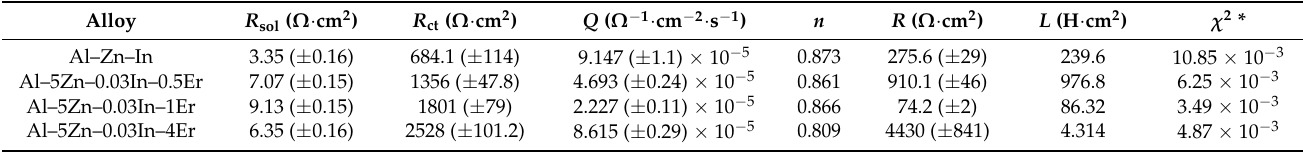
Table 3. Fitting values of EIS.